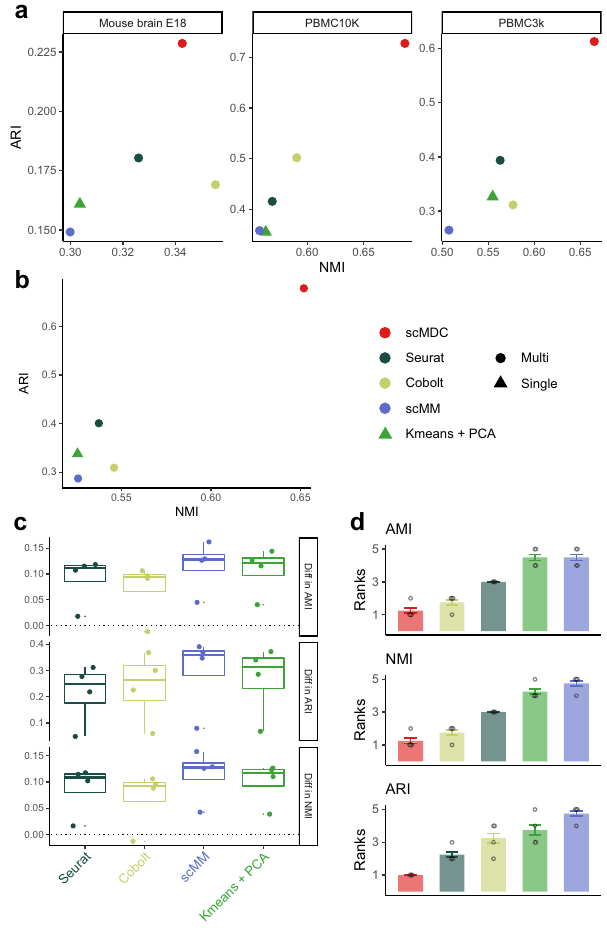
Fig. 3 | Clustering performance of scMDC and the competing methods on dif- ferent SMAGE-seq datasets. All the methods are tested on three one-batch data- sets ( a , n = 3) and one two-batch dataset ( b , n = 1). In panels ( a ) and ( b ), clustering performance is illustrated in a two-dimensional manner with ARI as the Y -axis and NMI as the X -axis. Circles stand for the results of the multi-omics methods and triangles stand for the results of the single-omics methods. The differences between the performance of scMDC and the competing methods are shown in boxplots ( c , n = 4). Each boxplot shows the minimum, fi rst quartile (Q1), median, third quartile (Q3), and maximum of data. The minimum and maximum are the smallestdatapointthatisequaltoorgreaterthanQ1 − 1.5*IQRandthelargestdata point that is equal to or less than Q3 + 1.5 * IQR, respectively. Each data point (a differenceinperformanceinadataset) isshownby a dot. We also summarizedthe performance of each method by showing the averaged ranks ( d , n = 4). Each data point(arankofamethodinadataset)isshownbyadotandthestandarderrorsare shown by the error bars. In panels ( c ) and ( d ), clustering performance is evaluated by AMI, NMI, and ARI. Source data is provided as a Source Data fi